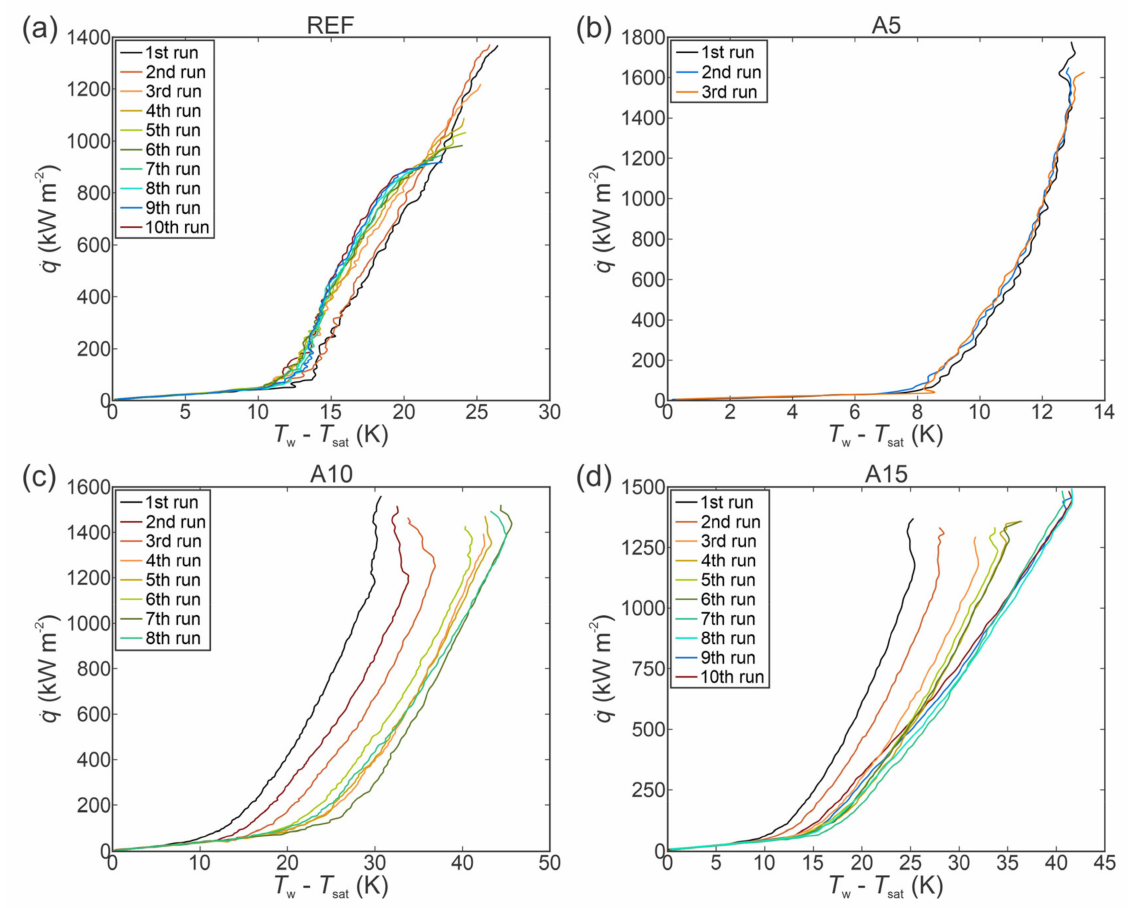
Figure 3. Pure water boiling curves on the untreated reference surface ( a ) and surfaces etched for 5 min ( b ), 10 min ( c ) or 15 min ( d